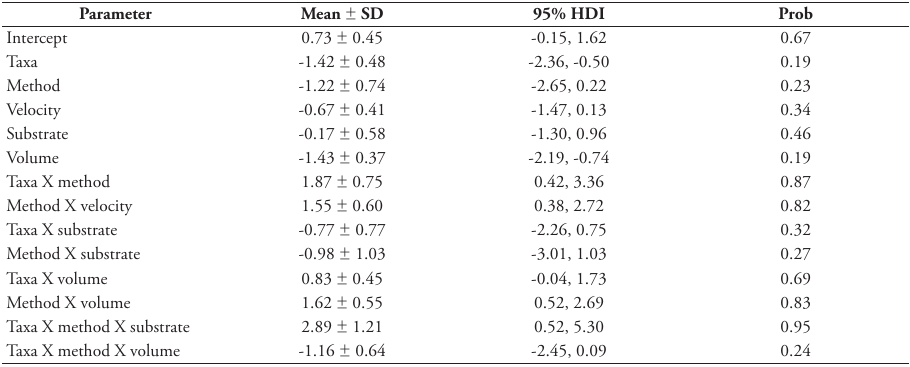
Table 2. Detection probability estimates from the final model for cavefishes and cave crayfishes using environmental DNA (eDNA) and visual surveys. Estimates for each parameter included in the detection model are reported on the logit scale as the mean ± standard deviation (SD) with a 95% high density interval (HDI). Mean values are reported as detection probabilities (Prob) by completing a logit trans- formation. The reference categories for categorical variables were visual surveys, water not flowing, cave crayfishes, and coarse